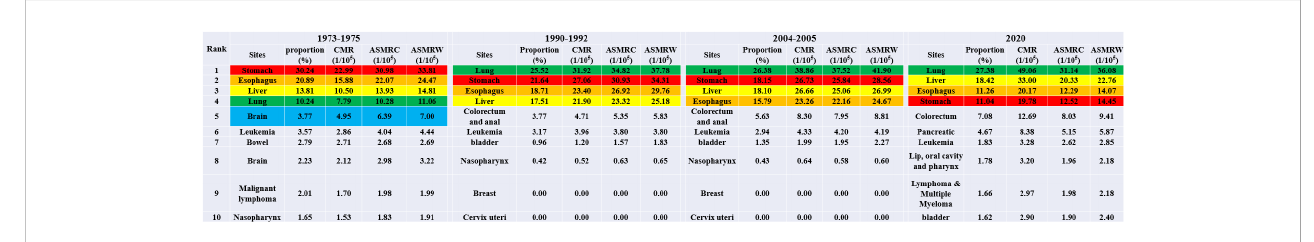
FIGURE 2 The top 10 cancer rank in male during the four periods in Inner Mongolia.